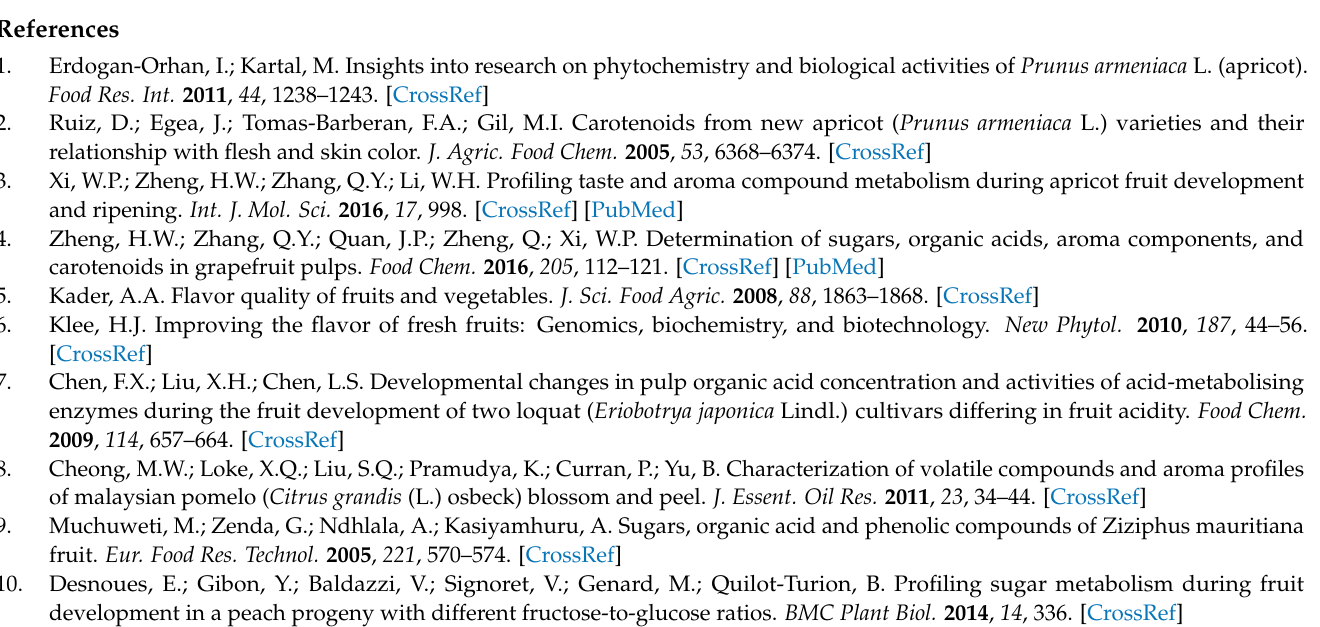
signal correction and partial least squares-discriminant analysis. Figure S2. The KEGG enrichment analysis. Figure S3. Primary metabolites detected by UPLC-MS/MS during four fruit developmental stages. A: Free fatty acids, B: Phenolic acids. Figure S4. Representative chromatograms of HPLC anal- ysis. Table S1. 592 primary metabolites detected by UPLC-MS/MS. Table S2. Differential metabolites in different comparison groups. Table S3. Common differentially accumulation metabolites. Table S4. The test ranges, regression equations, correlation coefficients, and retention